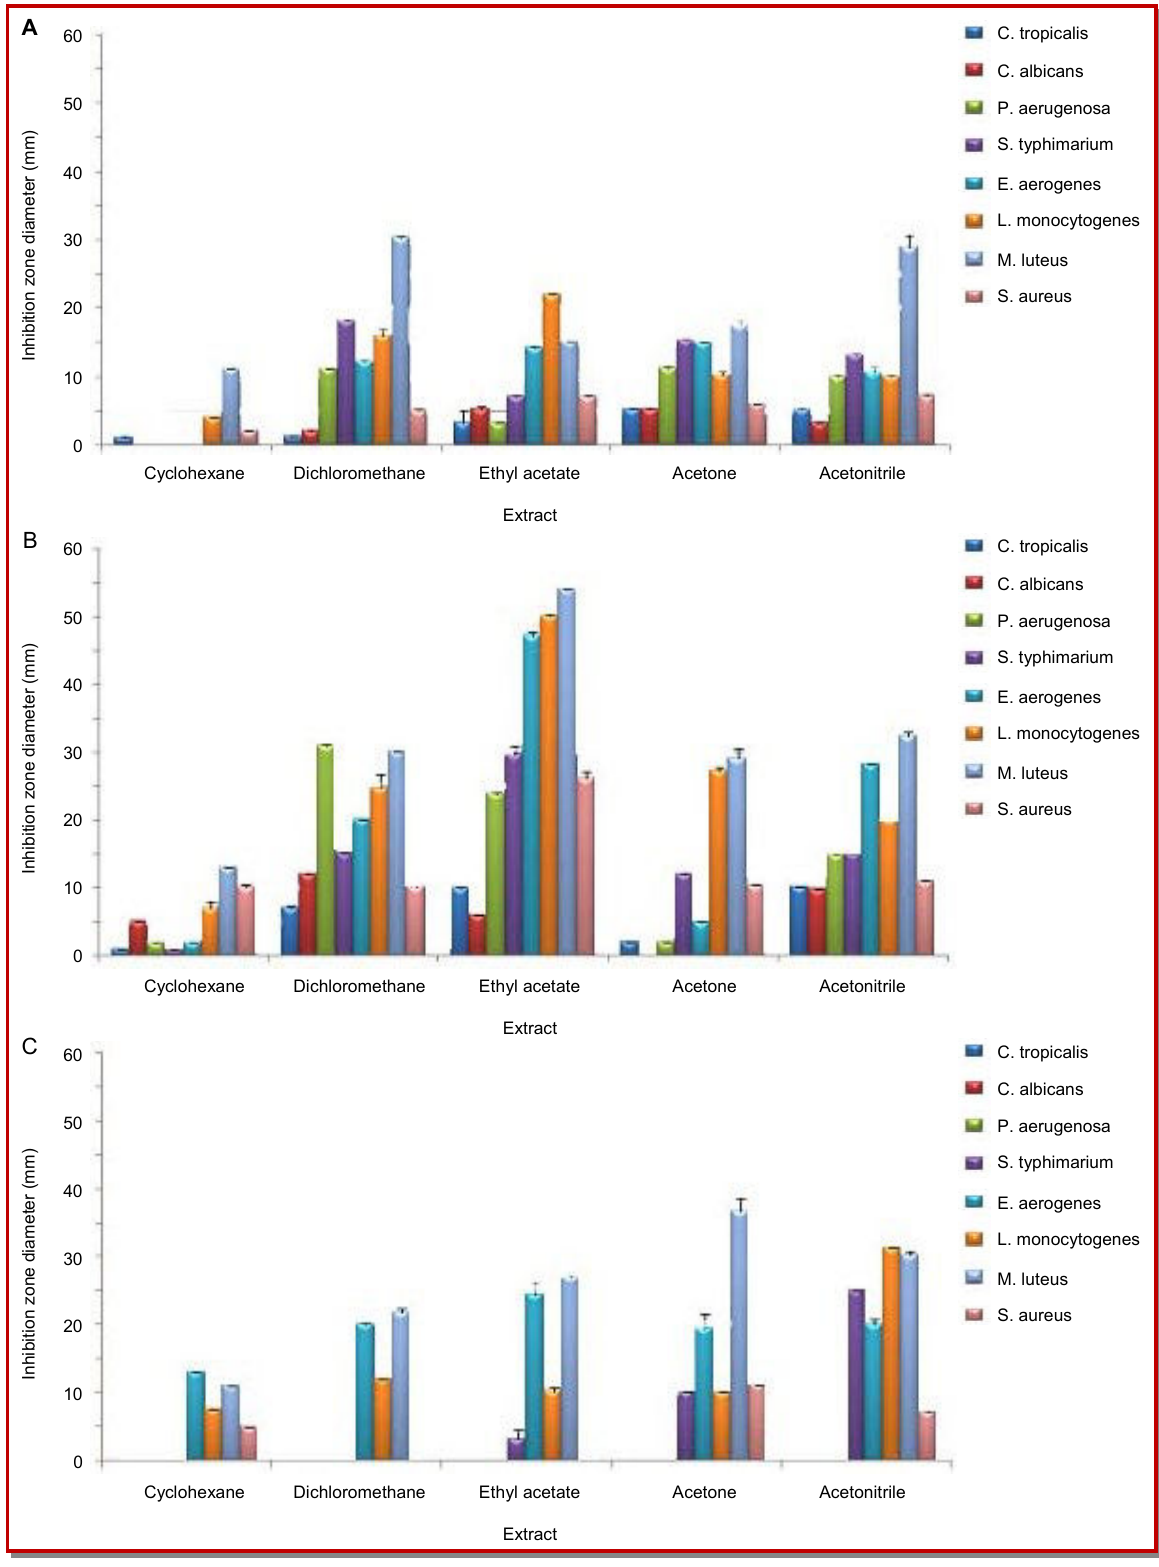
F igure 3: N. glauca extracts antimicrobial activities by agar diffusion test (inhibition zone in mm). (A) stems extracts activities, (B) leaves extracts activities, (C) flowers extracts